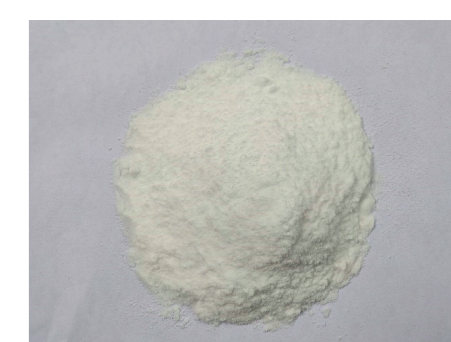
Figure 1: Anhydrous sodium sulfate.